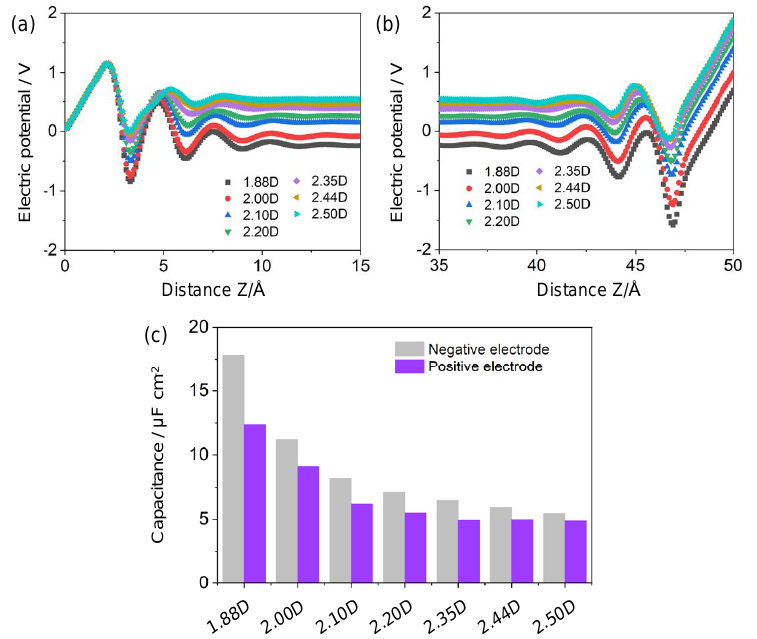
Figure 4. Electric potential distributions φ (z) near the ( a ) negative and ( b ) positive graphene elec- trodes; ( c ) specific capacitance for graphene electrodes at different solvent polarities.